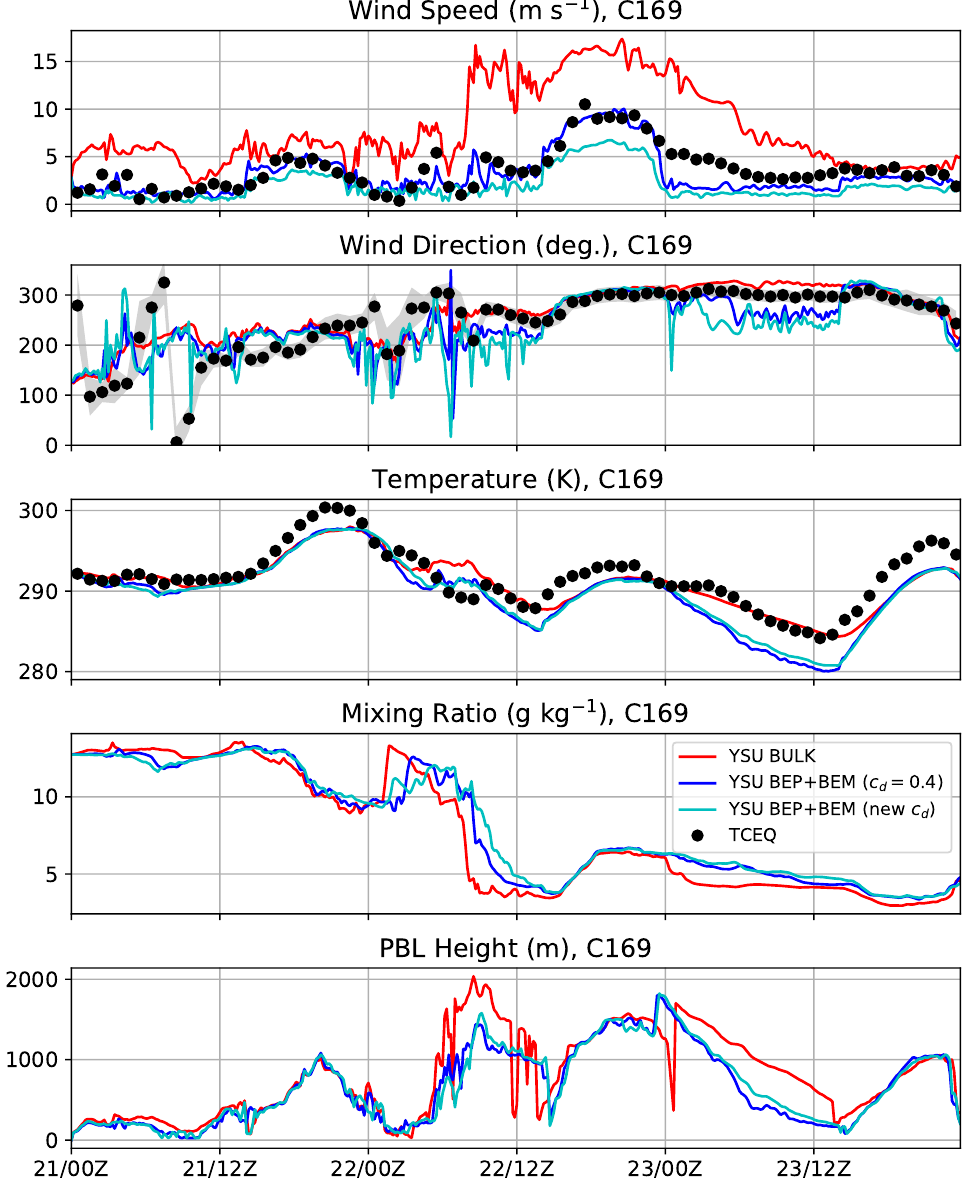
Figure 7. Measured and WRF model simulation time series at TCEQ station C169 in an LIR region. Measurements are reported as hourly averages (filled black circles), and simulation output is shown at a frequency of 10 min (colored lines). In the wind direction plot, the gray shading denotes the observed standard deviation at the TCEQ station. The stations did not measure water vapor mixing ratio or PBL